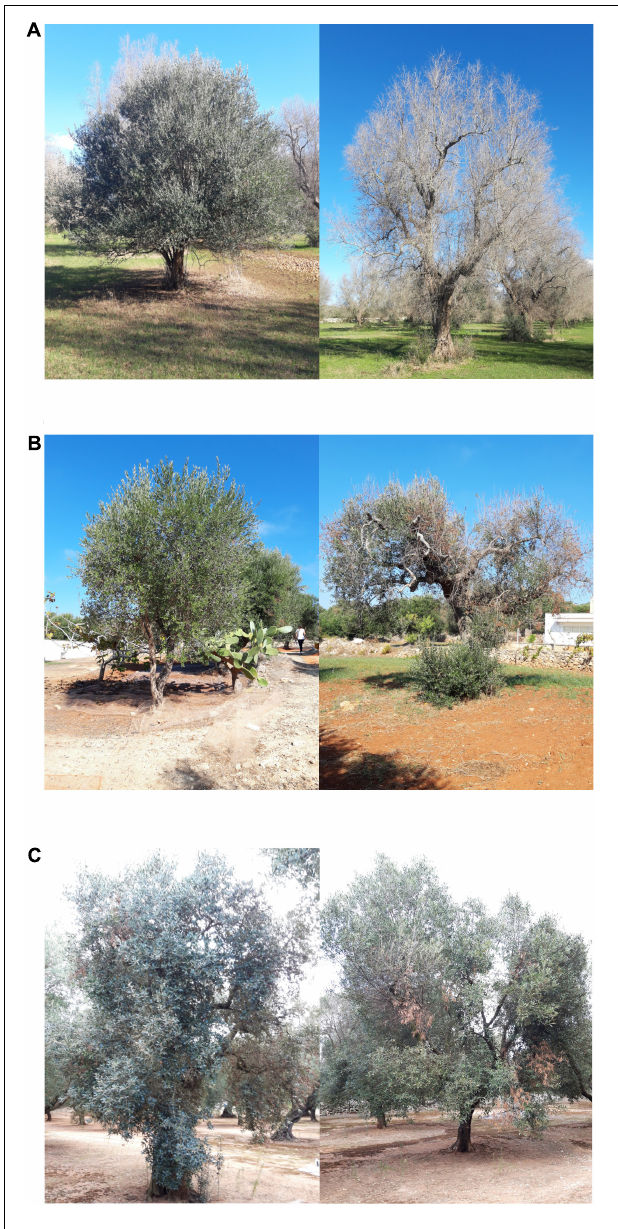
FIGURE 2 | Phenotypes of plants monitored in this study (left) and respective controls (right) for (A) (cid:49) S = 3, (B) (cid:49) S = 2, and (C) (cid:49) S = 1.